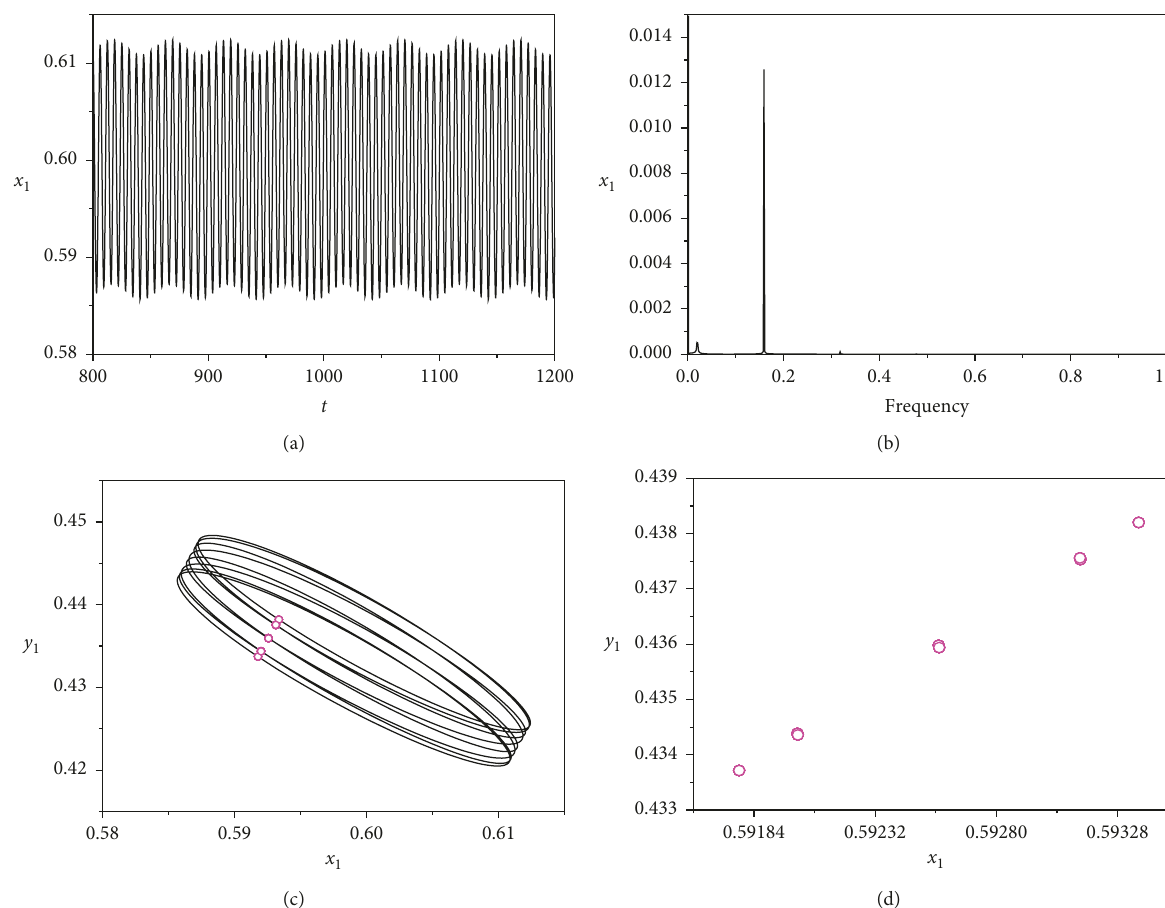
Figure 19: ω � 2.20 and ϕ � 0.02: (a) displacement response; (b) frequency spectrum; (c) rotor orbit; (d) Poincar´e maps.